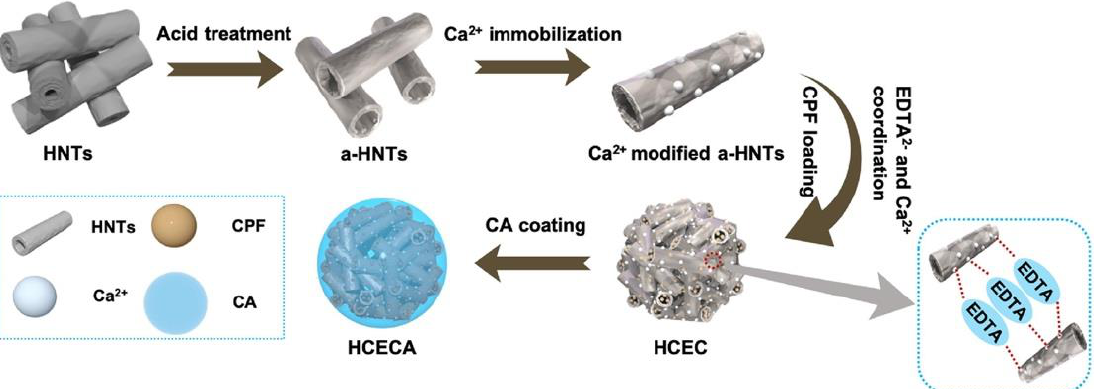
Figure 12. Schematic representation of the HNT/CPF pesticide. Reproduced with permission from [86].